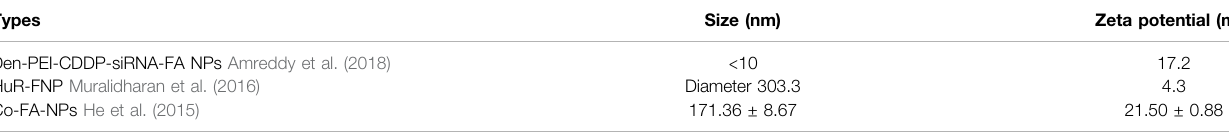
TABLE 7 | Folate Receptor antibody for active targeting of nanoparticle drug delivery